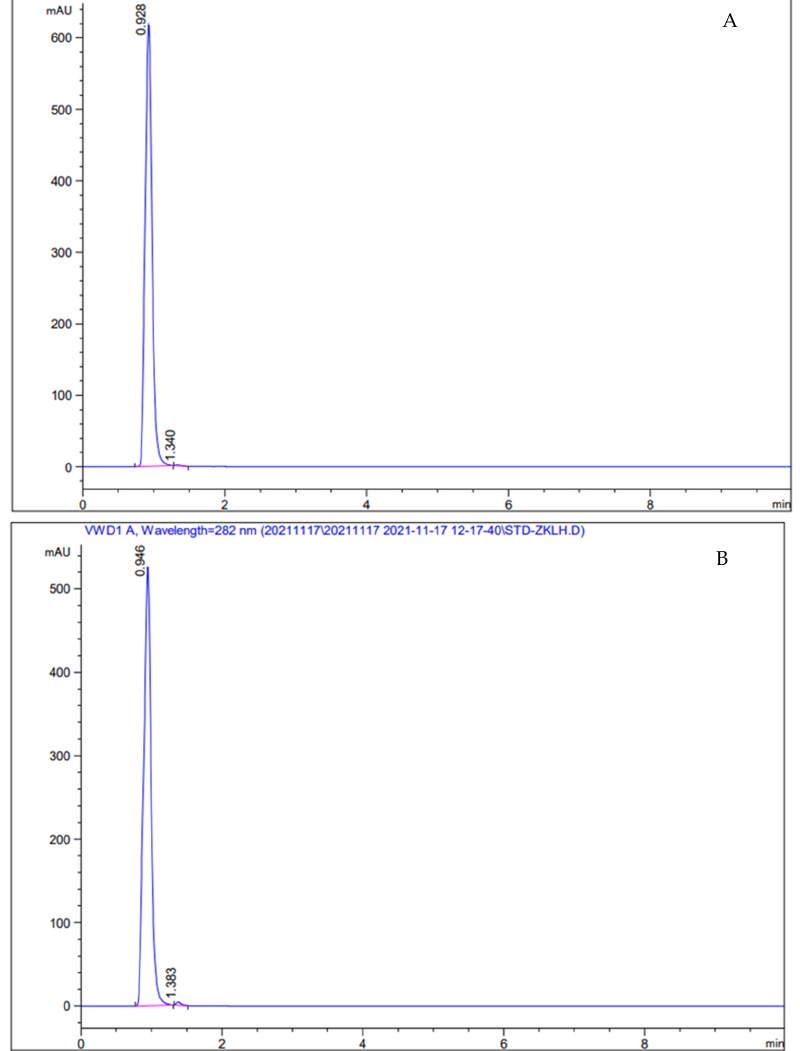
Figure 1. HPLC diagram of ( a ) naringin-refined products and ( b ) its standards （ the chromatographic peak type and retention time of both the refined and standard products were approximately the same ） .